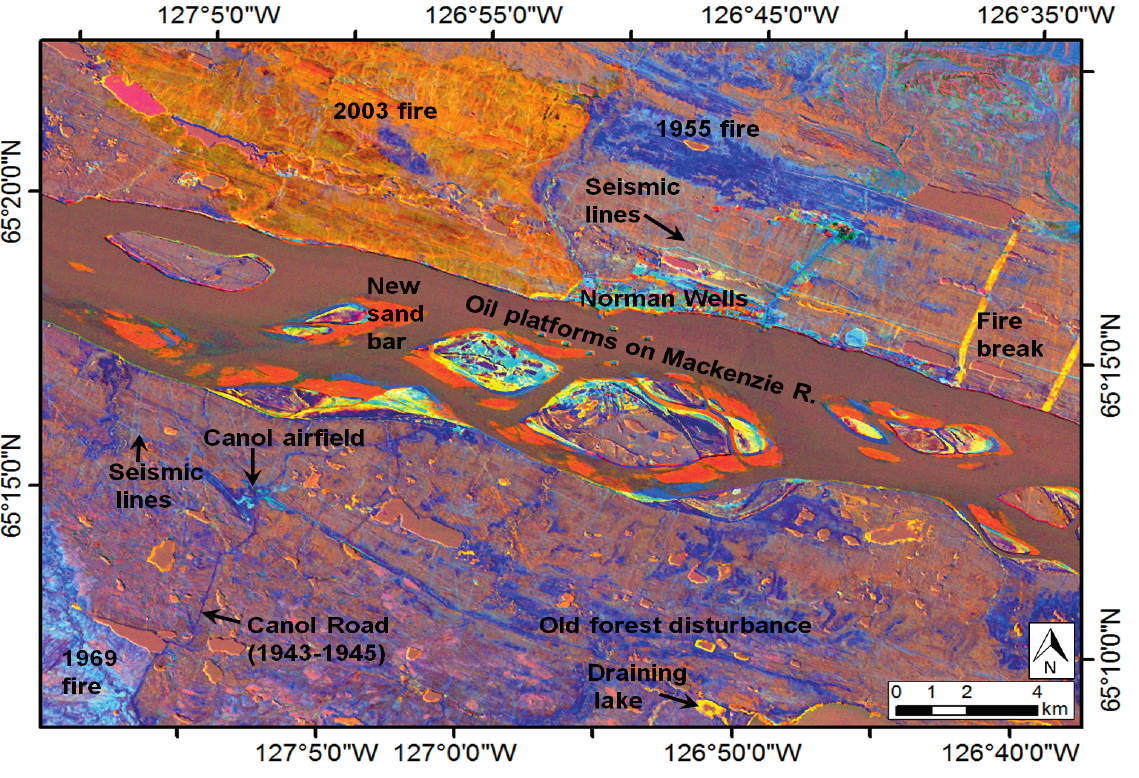
Figure 15. TC trend image for area surrounding Norman Wells, which has been heavily developed for oil and gas during the past 60